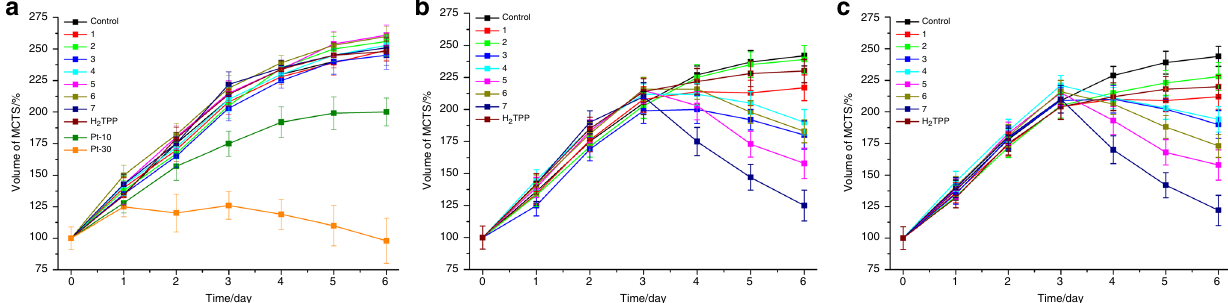
Fig. 3 Tumor growth inhibition assay in HeLa MCTS. Change of the volume in MCTS in correlation to the time of the treatment. The MCTS were treated with compounds 1 – 7 (20 μ M, 2% DMSO, v %), H 2 TPP (20 μ M, 2% DMSO, v %), and cisplatin (10 μ M and 30 μ M). The MCTS were a strictly kept in the dark, b exposed to 1P irradiation (500 nm, 16.7 min, 10.0 mWcm − 2 , and 10 J cm − 2 ), c exposed to 2P irradiation (800 nm, 10 J cm − 2 with a section interval of 5 μ m) on day 3. The error bars correspond to the standard deviation of the three replicates.